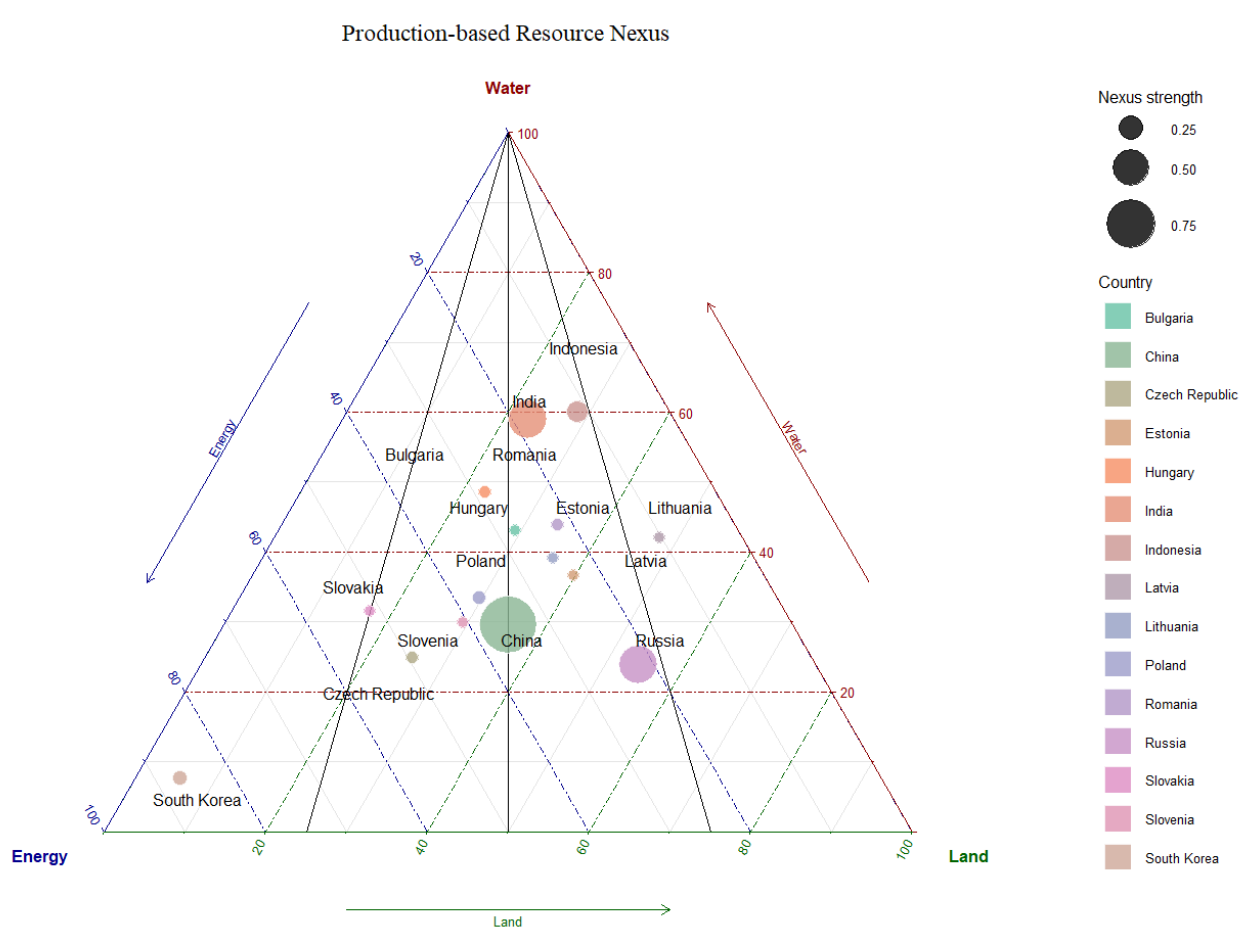
Figure 6. Nexus strength results by country based on the production viewpoint. Lines that cut the point position represent aggregated usage of a given resource. Size of the point/or circle inside the triangle shows the combined contribution of the three resources. Location of a point within the triangle provides a series of key information that can be used to compare its resource use combination with other countries.